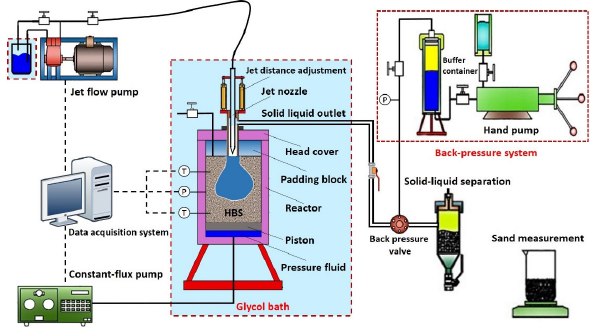
Figure 1. Schematic of the experimental apparatus.